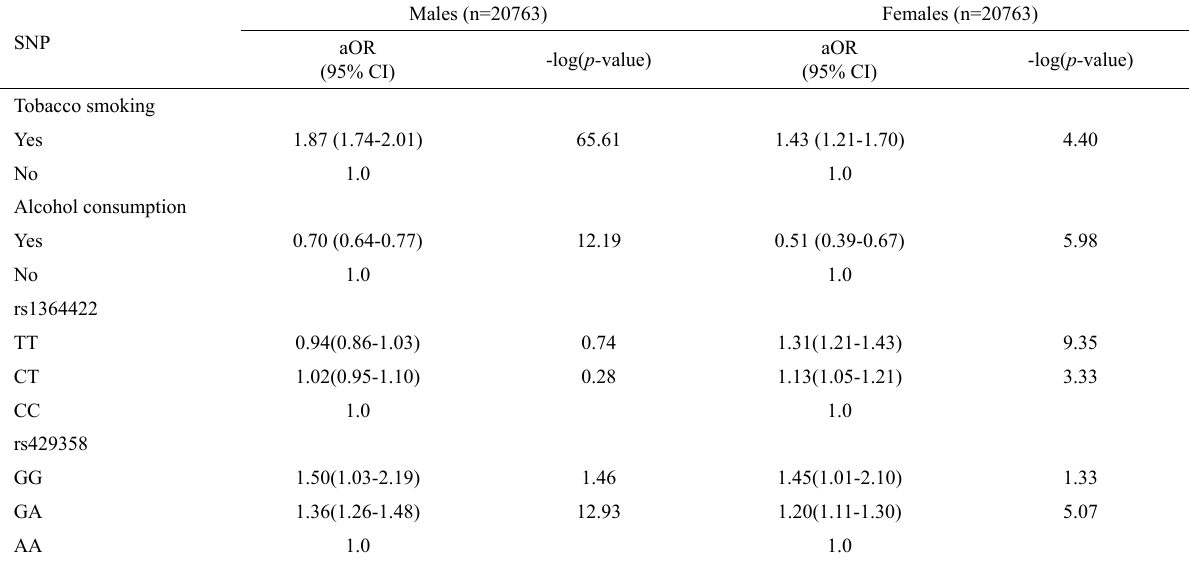
aOR (95% CI): The odds ratios and 95% confidence intervals of relating to low-HDL-C were estimated for tobacco smoking and alcohol consumption after adjusting age; and estimated for rs1364422 and rs429358 after adjusting age, smoking and alcohol characteristics, revealing its relationship to decreased insulin secretion, sensitivity, and body weight, but to increased blood glucose levels (Brunham et al. , 2007; de Haan et al. , 2014; Sanchez-Aguilera et al. , 2018).